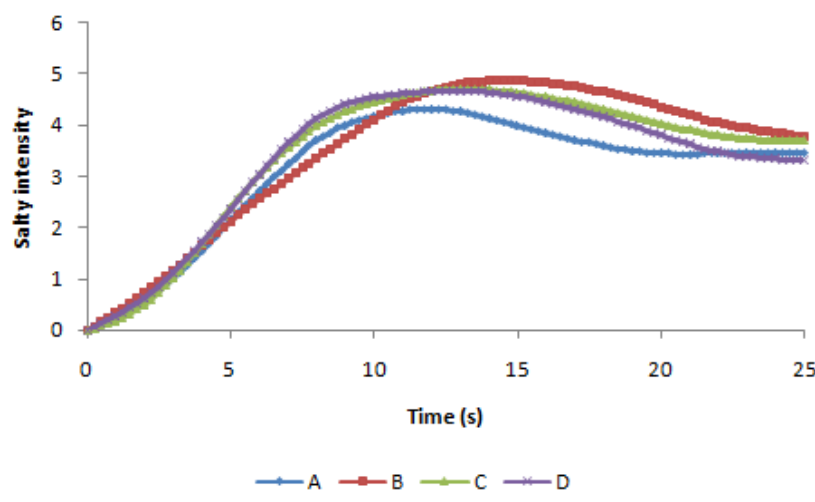
Figure 1 - Graphical representation of the salty taste intensity over time for margarines: a (control - Without sodium reduction), b (20.8% less sodium), c (33% less sodium) and d (47.4% less